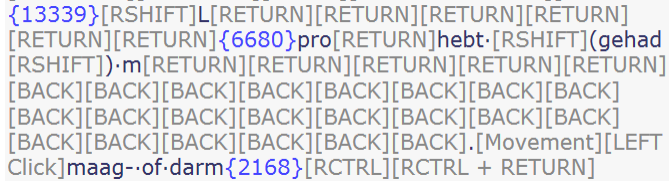
Figure 17. Example of how a translation is produced in